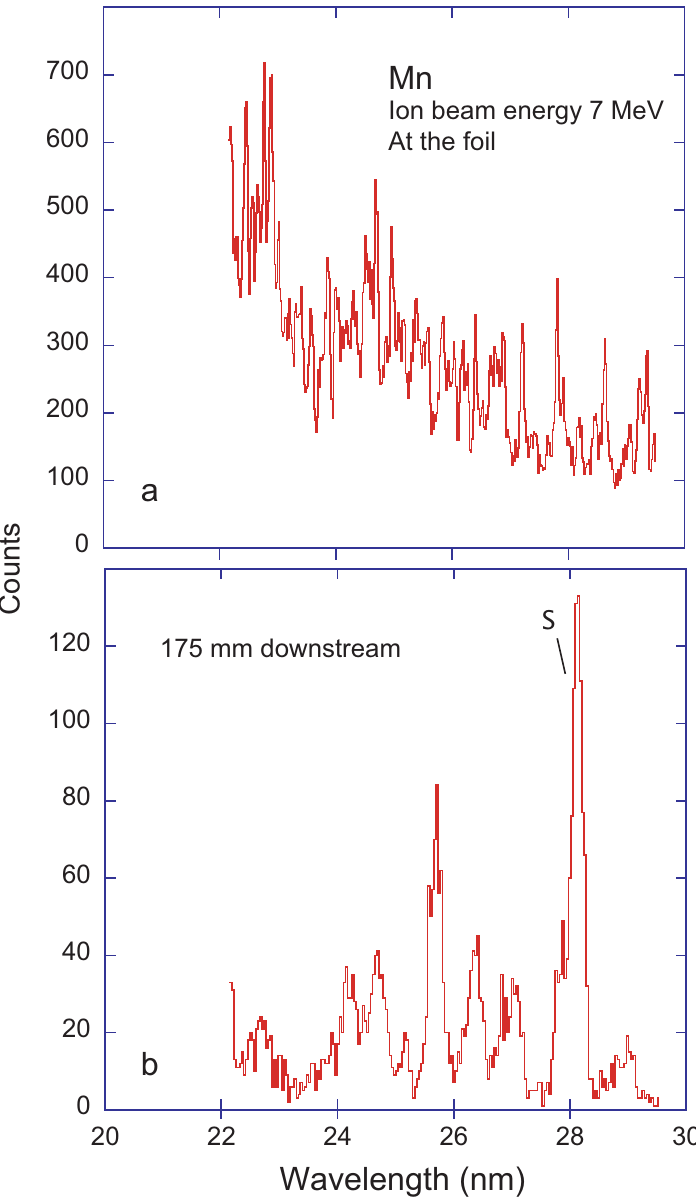
Figure 18. Beam-foil spectra of Mn at an ion beam energy of 7MeV. ( a ) Observation at the foil, line width (FWHM) 0.06nm; ( b ) observation 175mm downstream of the foil (delay 20ns), line width (FWHM) 0.18nm. The line group at a wavelength of 28nm comprises an intercombination transition array in the S-like spectrum